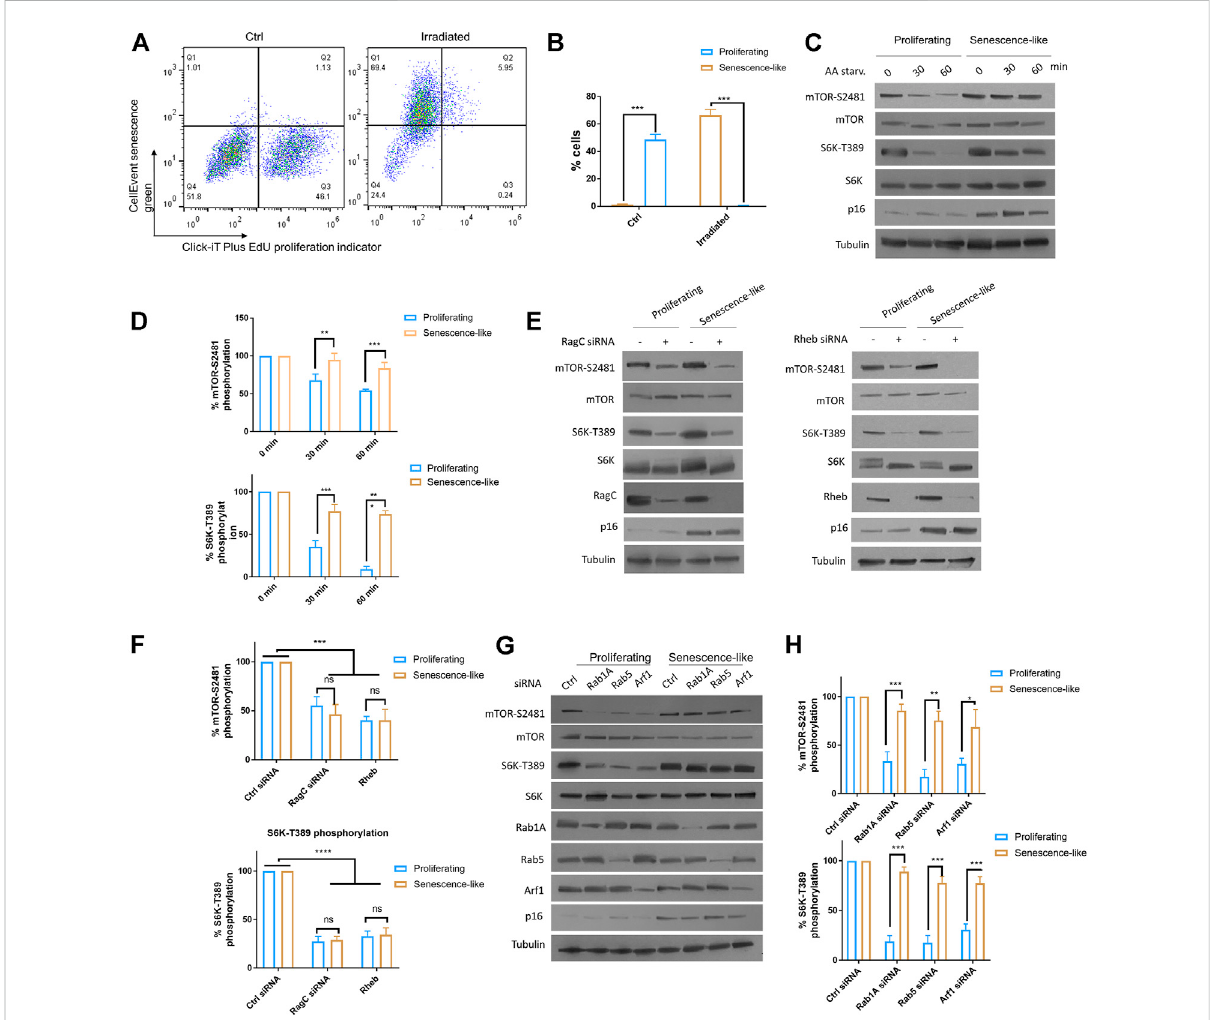
Rag and Rheb but not Rab1A, Rab5, Arf1 were required for persistent mTOR activity in senescence-like HepG2 cells. (A) HepG2 cells were irradiated with 20 Gy X-ray and maintained on fresh medium over 2 weeks. Non-irradiated cells and irradiated cells were examined for senescence marker (CellEvent senescence green) and proliferating marker (Click-iT Plus EdU) by fl ow cytometry. All samples were gated through the same standard.Representativedataareshown. (B) Quanti fi cationofsenescence-likecellpopulationsfrom3separateexperiments. p < 0.001(***). (C) mTOR activity was insensitive to AA starvation in senescence-like HepG2 cells. Proliferating and senescence-like HepG2 cells were cultured in medium without AA and serum for 30 min or 1 h. Total proteins were separated by reduced SDS-PAGE. mTOR-S2481 and S6K-T389 phosphorylation were examined by Western blotting.Representative data are shown. (D) Quanti fi cation ofmTOR activity bymTOR-S2481 and S6K- T389. Blotswerequanti fi edbyImageJand normalized to control (100%) for each experiment. N= 3experiments weretested by Student ’ s t -test. p < 0.001(***). (E) Persistent mTOR activity was dependent on Rag and Rheb GTPases. RagC and Rheb were knocked down by siRNA for 48 h mTOR- S2481 and S6K-T389 were examined by Western blotting. Representative data are shown. (F) Quanti fi cation of multiple experimental results in (E) . Blots were quanti fi ed by ImageJ and normalized to control (100%) for each experiment. N = 3 experiments were tested by Student ’ s t -test. p < 0.0001(****), ns, not signi fi cant. (G) mTOR activity was insensitive to knockdowns of Rab1A, Rab5 and Arf1 expression in senescence-like HepG2cells.Geneexpressionswereknockeddownbytransfectingcellswithspeci fi csiRNAsfor48 h.IndicatedproteinswereexaminedbyWestern blotting. Representative data are shown. (H) Quanti fi cation of mTOR-S2481 and S6K-T389 phosphorylation in (G) . Blots were quanti fi ed by ImageJ and normalized to control (100%) for each experiment. N = 3 experiments were tested by Student ’ s t -test. p <